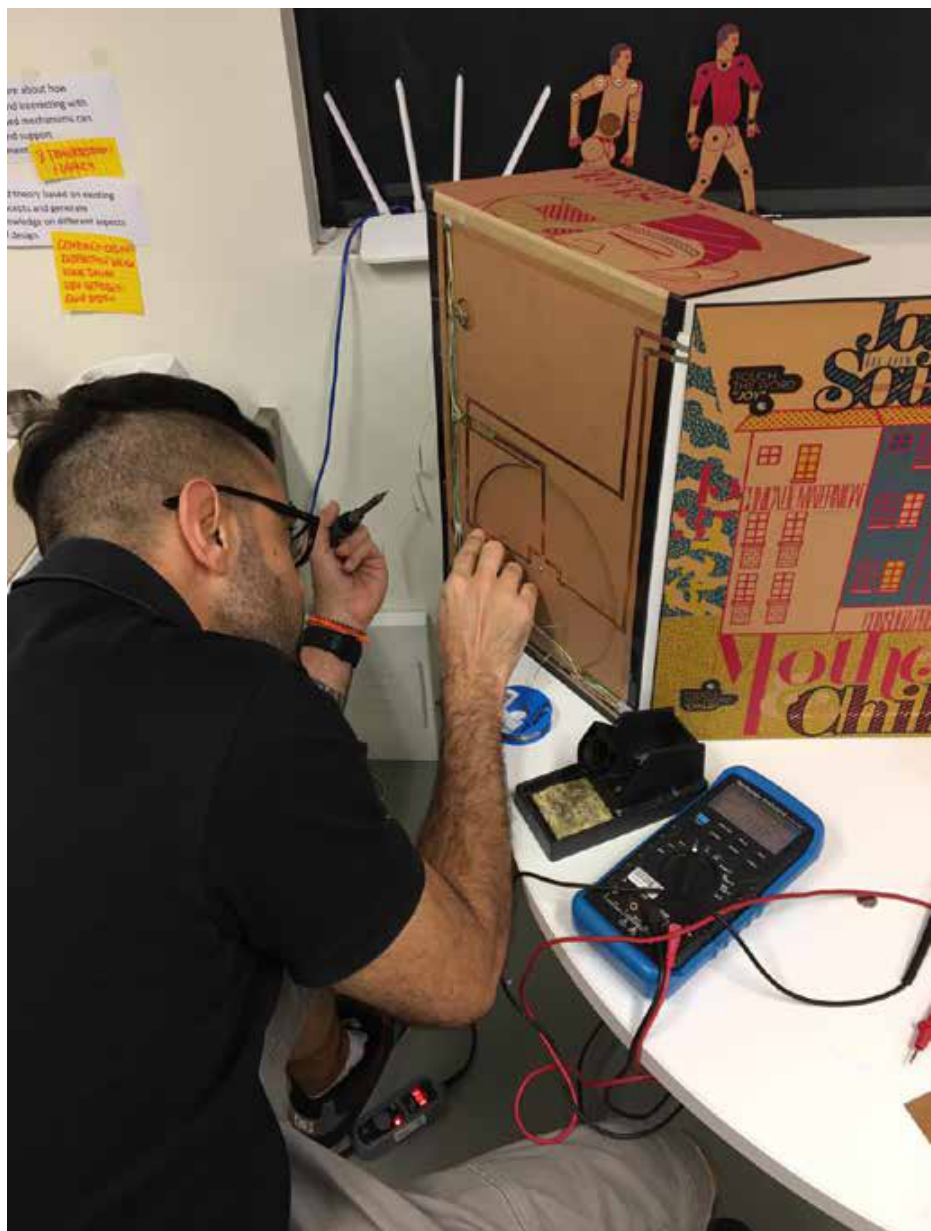
Figure 1: (previous pages): Transcription and annotations of the interaction process. Distinct attention is paid in this transcript to the nested modalities and how they contribute towards the narrative experience. Source: author.